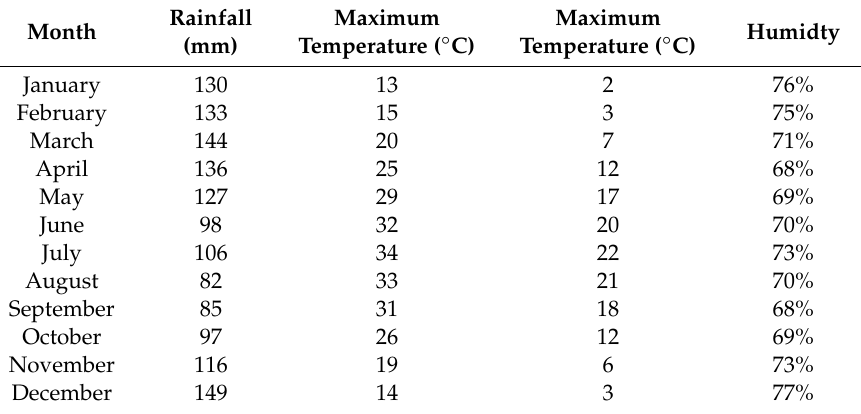
Table 1. Monthly weather data in Big Sunflower River